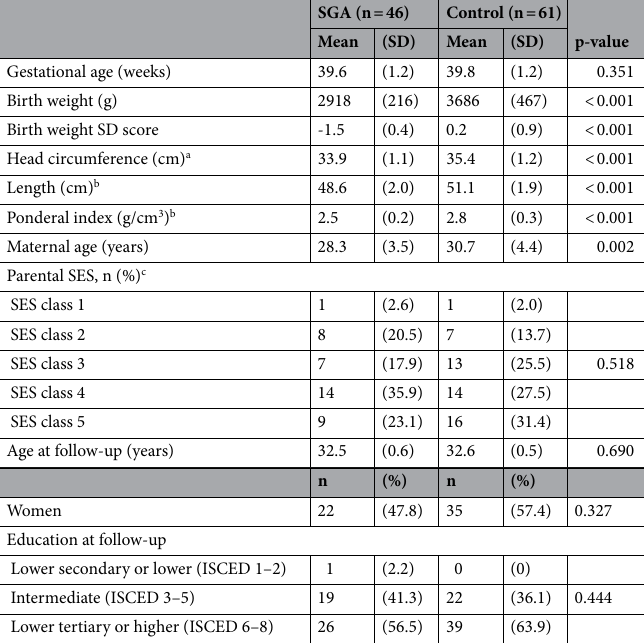
Results were unchanged regarding anthropometric measures and body composition when we performed sensitivity analyses by excluding eight participants born SGA and five controls who were pregnant, had